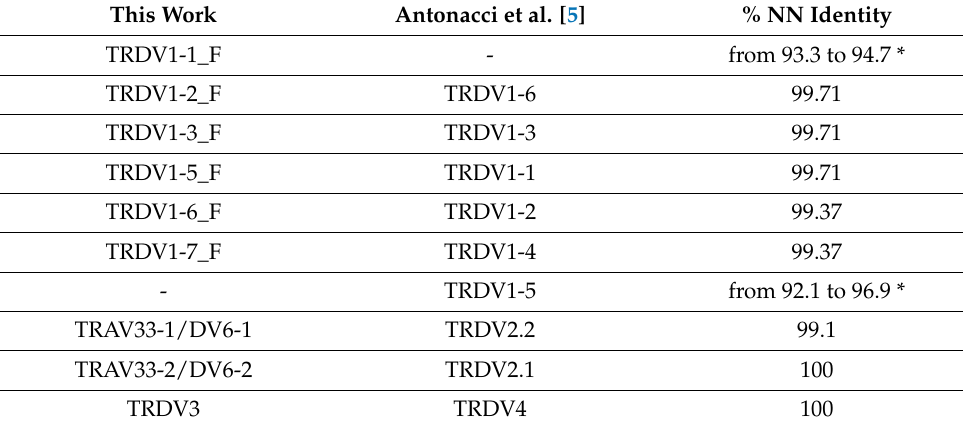
Table 2. Correspondence between TRDV genes and